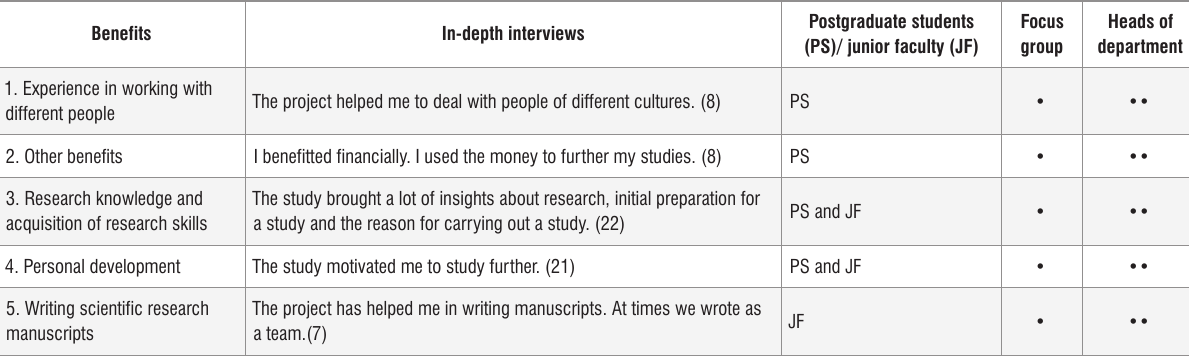
Consolidated views from individual in-depth interviews, the focus group discussion and individual heads of department interviews Benefits In-depth